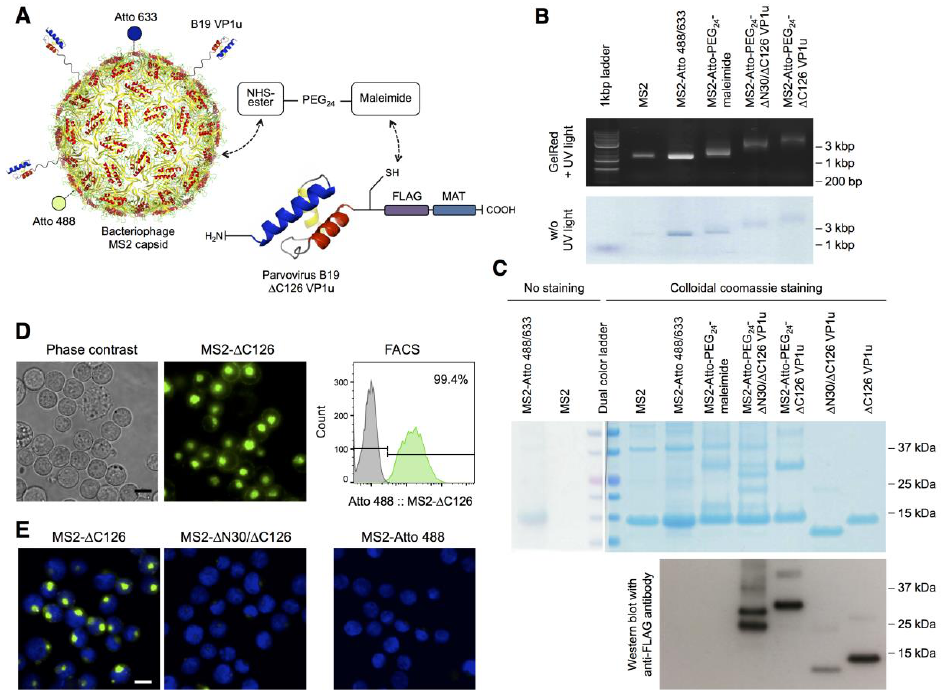
Figure 1. Bioconjugation of the B19 viral protein 1 unique region (VP1u) with the bacteriophage MS2 capsid, and internalization of the bioconjugate on erythroleukemic UT7/Epo cells: ( A ) Schematic depiction of the bioconjugation and labeling strategy of the bacteriophage MS2 capsid (PDB ID: 1MST [28]). The recombinant ∆ C126 VP1u protein with a C-terminal metal affinity tag (MAT), FLAG tag, and a unique cysteine was coupled to the MS2 capsid using the heterobifunctional maleimide-PEG 24 -N-hydroxysuccinimide ester (NHS-PEG 24 -maleimide) crosslinker. The NHS-ester was conjugated to the surface lysines of the MS2 capsid and the maleimide group reacted with the unique cysteine in the VP1u. In addition, the capsid was labeled with the NHS-Atto 488 (green) and NHS-Atto 633 (blue) dyes; ( B ) Migration of the wild-type (WT) and bioconjugated MS2 capsids by agarose gel electrophoresis and detection of encapsidated RNA with GelRed. Capsid proteins are labeled with NHS-Atto dyes (green-blue); ( C ) Sodium dodecyl sulfate polyacrylamide gel electrophoresis (SDS-PAGE) and Western blot analysis of the MS2 capsids, recombinant VP1u proteins, and the bioconjugates. Recombinant VP1u and MS2-VP1u conjugates were detected with an anti-FLAG antibody. In the Western blot, the transfer of low molecular weights proteins was less efficient; therefore, the detected signal did not quantitatively reflect the original and relative input of the proteins; ( D ) Uptake of the fluorescent MS2- ∆ C126 VP1u into UT7/Epo cells and detection of the internalized capsids in living cells by fluorescence microscopy and fluorescence-activated cell sorting (FACS); ( E ) Fluorescence microscopy images of the MS2- ∆ C126 VP1u and the Atto-labeled but internalization-deficient controls MS2- ∆ N30/ ∆ C126 VP1u and MS2 (63 × magnification). Scale bar: 15 µ